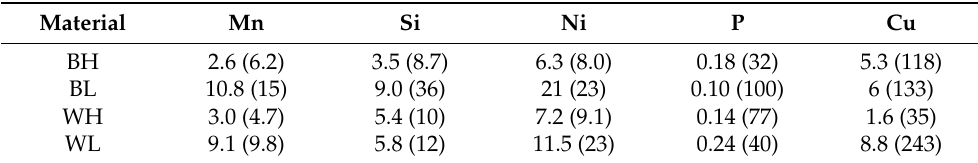
Table 5. Solute atom cluster composition in at%. Only elements with significant absolute amounts (>1%) and enrichment factors (>2) are listed; the enrichment factors are given in parentheses.